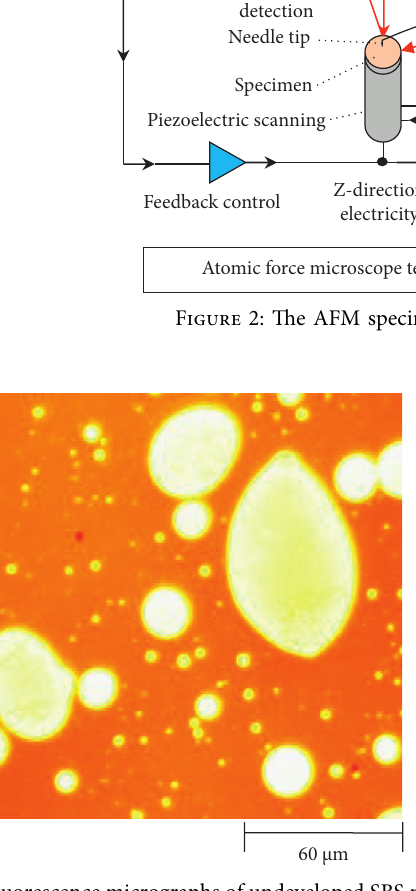
Figure 3: Fluorescence micrographs of undeveloped SBS modified asphalt with 0% content of APR.